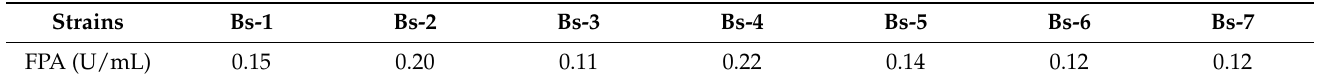
Figure 3. Saprophytic Bacilli are cellulase-producing strains. ( A – G ): Bacterial suspension of Bs-1 to Bs-7 were dipped and placed on the center of CMC-Congo red medium. Then the medium was cultured at 37 °C for 48 h. Table 1. Determination of cellulase activity.